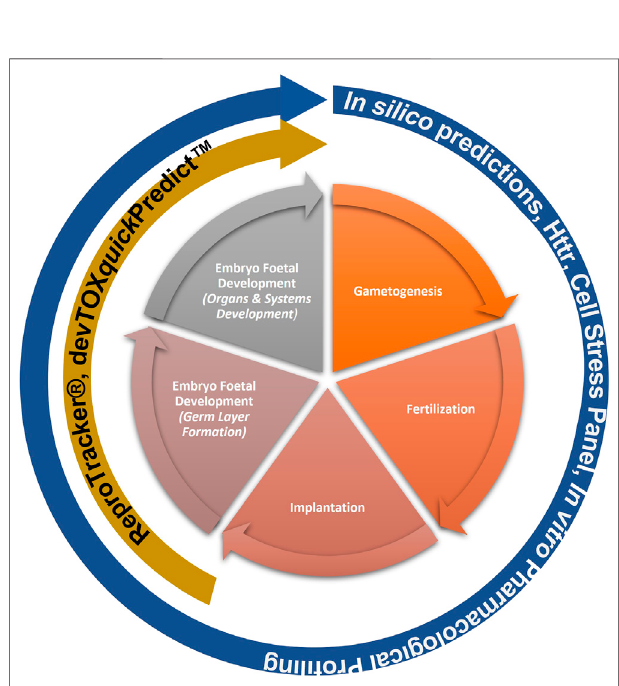
FIGURE 2 | NAMs within the Developmental and Reproductive Safety Framework evaluated for being protective of DART effects spanning the key stages in reproduction and